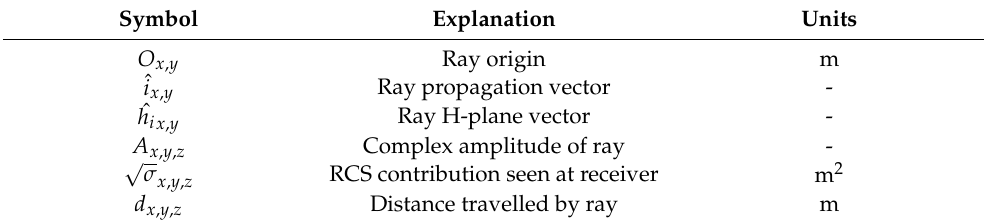
Table 2. Ray tube